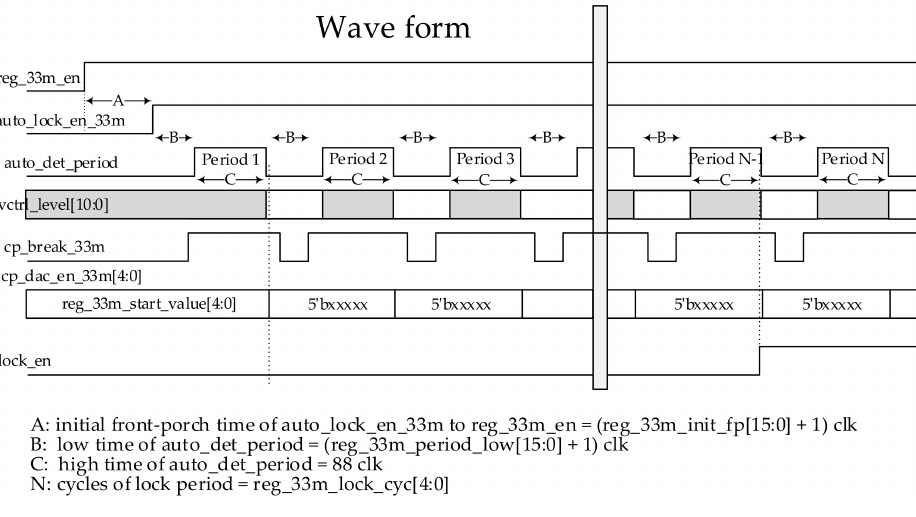
Figure 15. PLL locking instruction